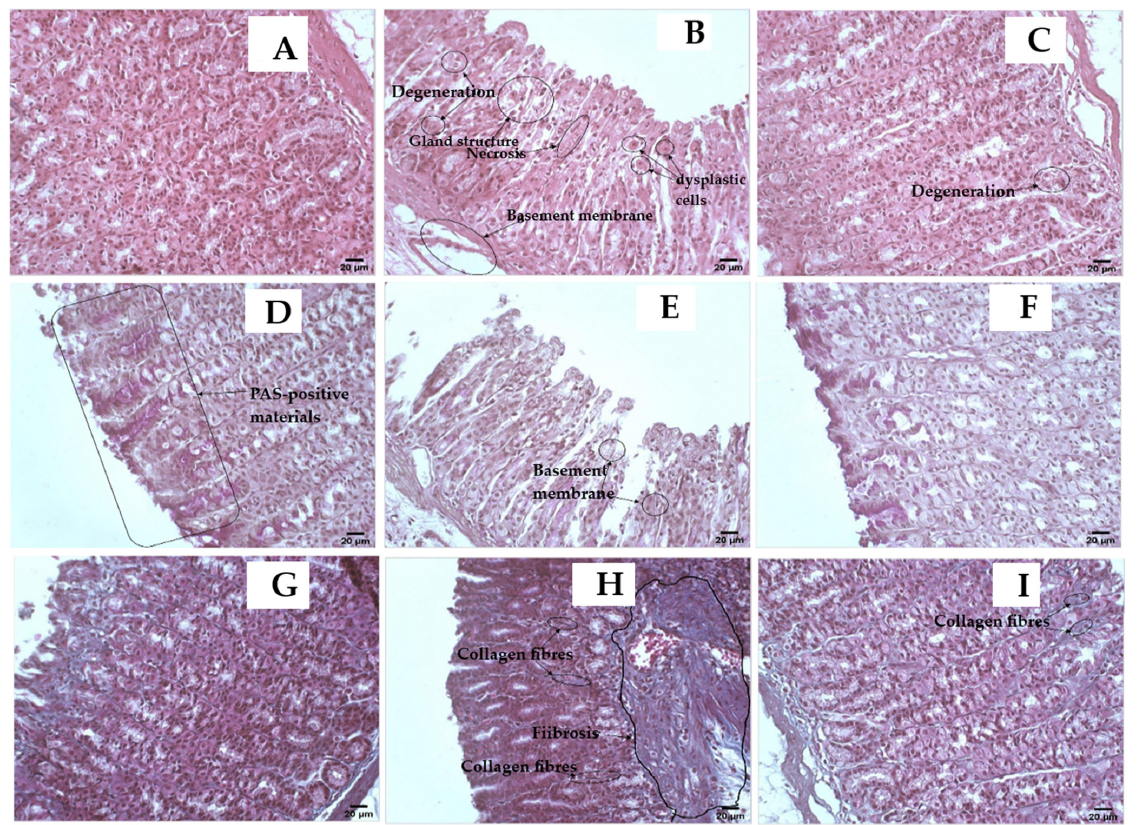
Figure 5. ( A – C ), Hematoxylin and eosin (H&E, magnification is ×400, scale bar is 20 μ ) stain,